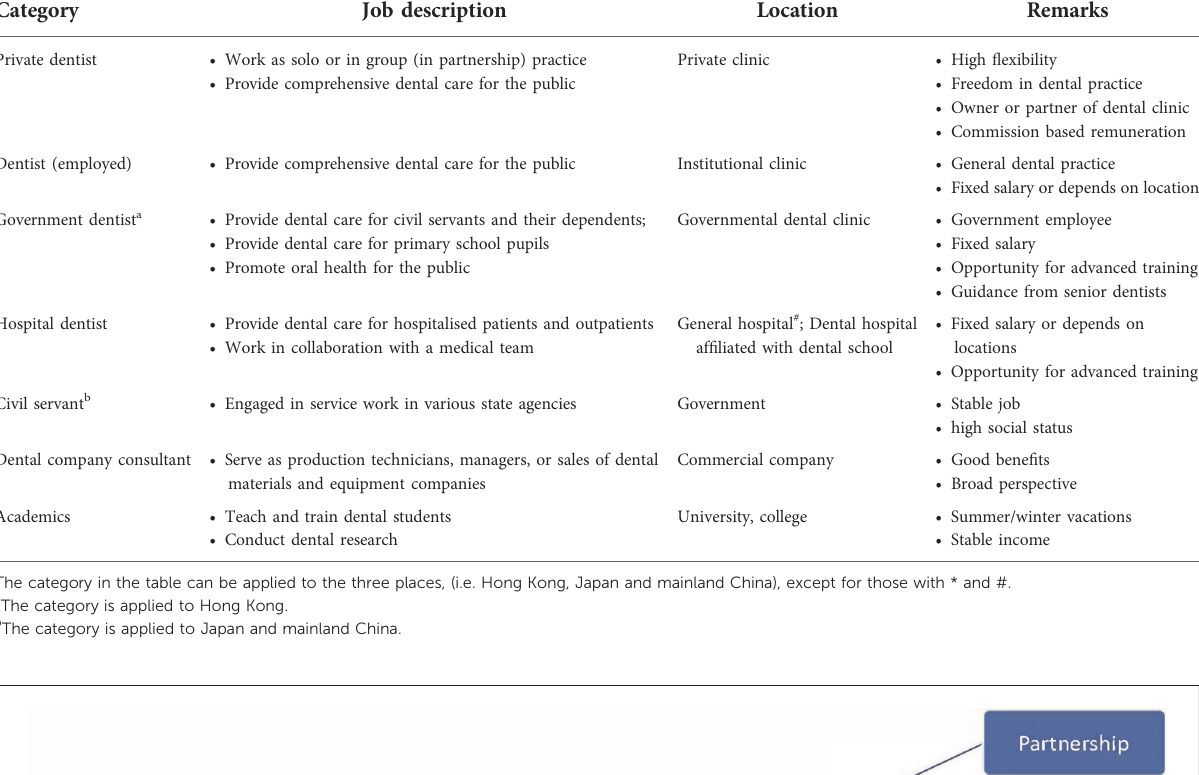
TABLE 1 Summary of career paths for dental graduates.